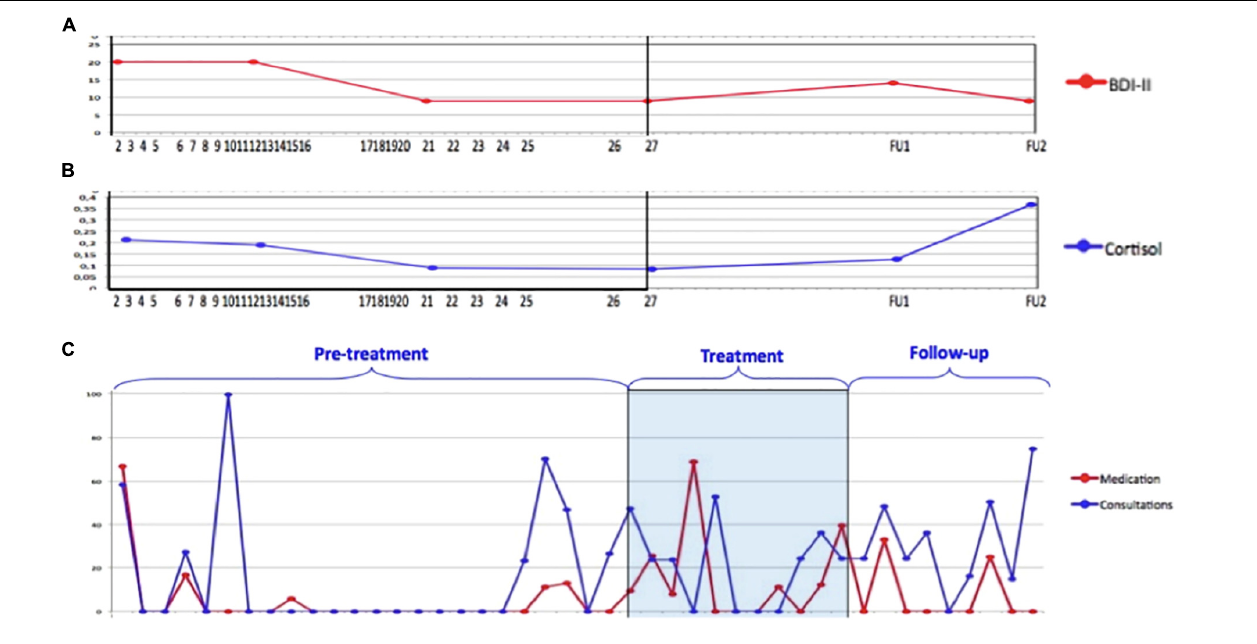
FIGURE 4 | Three different outcome or process measures for patient James (retrieved from Cornelis et al., 2017; reprinted with permission): (A) the BDI (Beck et al., 1988) from baseline to 1-year follow-up; (B) cortisol stress hormone measures from baseline to 1-year follow-up; (C) medical health care costs from years prior to 2 years after